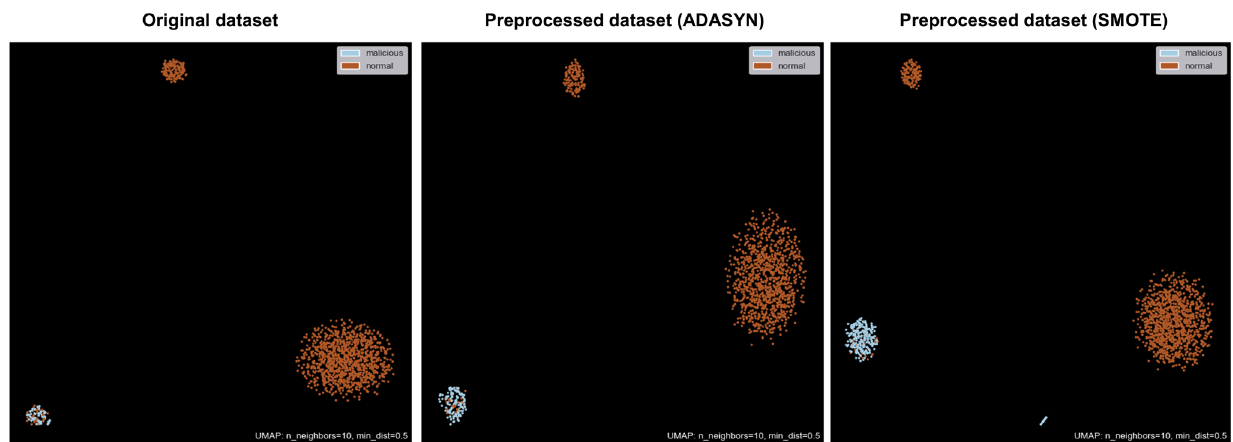
Figure 7. Data distribution plot of original dataset and preprocessed dataset (SMOTE).